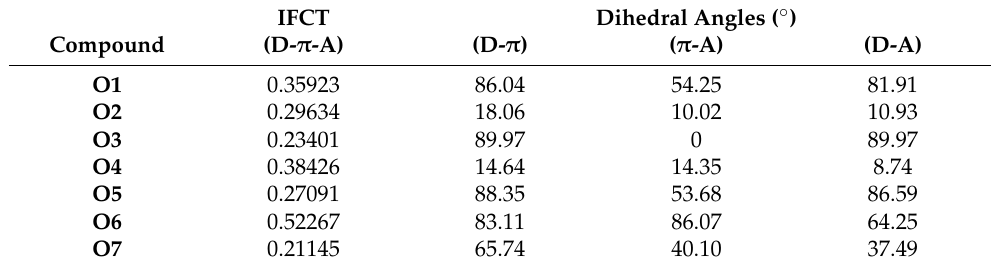
Table 13. Intra-fragment charge transfer and dihedral angles between fragments within compounds. IFCT